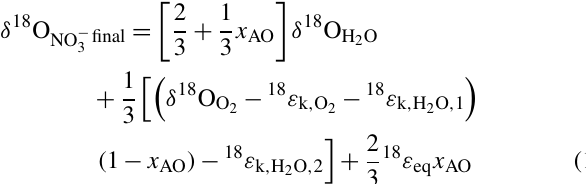
Sample δ 15 N-TN δ 18 O–H 2 O (‰) (‰) Artificial/inorganic fertiliser − 0 . 5 to + 0 . 7 – Cow manure/organic fertiliser + 6 to + 13 – Sediment (SOM) + 4 to + 5 – Stream water – − 5 . 5 to − 4 .